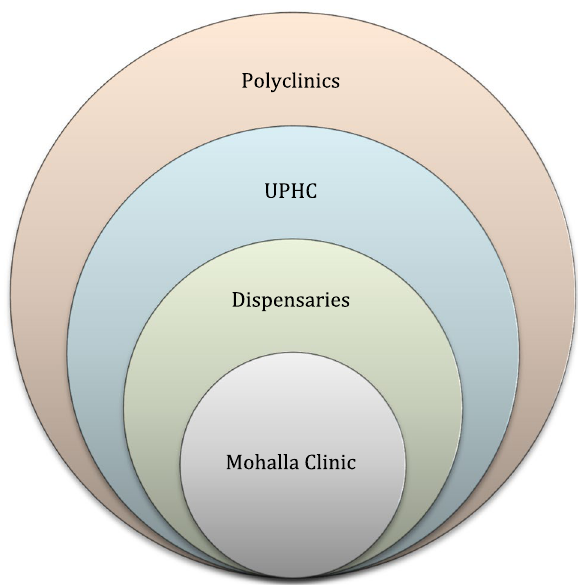
Fig. 2 A conceptual hierarchy model of existing healthcare delivery services in